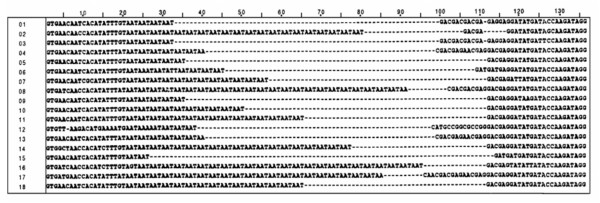
Alignment of nucleotide sequences of 18 Arachis species amplified using primer pair Ah11. Species analyzed: A. valida (1), A. triseminata (2), A. subcoreacea (3), A. cardenasii (4), A. guaranitica (5), A. batizocoi (6), A. repens (7), A. duranensis (8), A. paraguariensis (9), A. burkartii (10), A. ipaënsis (11), A. kuhlmannii (12), A. kempff-mercadoi (13), A. magna (14), A. hoehnei (15), A. decora (16), A. macedoi (17) and A. hypogaea (18). The sequences of all species comprised microsatellites, but the number of repeats varied a lot among them.